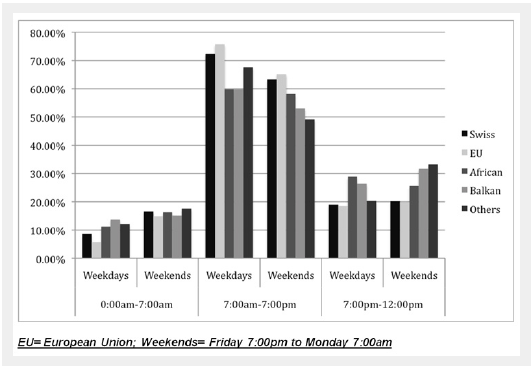
Figure 2 Distribution of patient admissions by time period and nationality on weekdays and weekends in percentages.